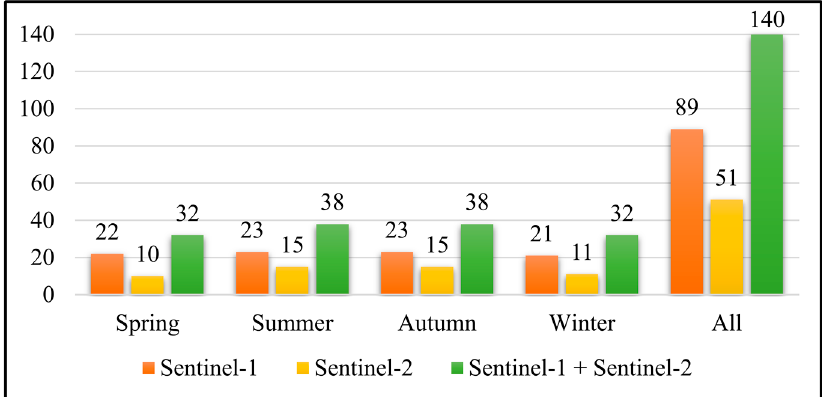
Figure 2. The numbers of Sentinel-1 and Sentinel-2 satellite images that were used in the mangrove classification. The data were acquired between 1 January 2020 and 1 January 2021.